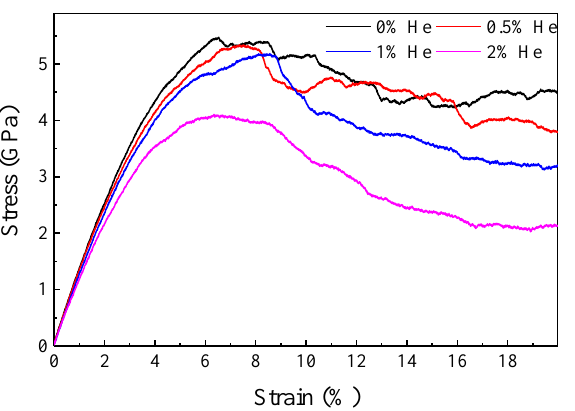
Figure 1. The stress–strain curves of nanocrystalline Fe with different He concentrations.